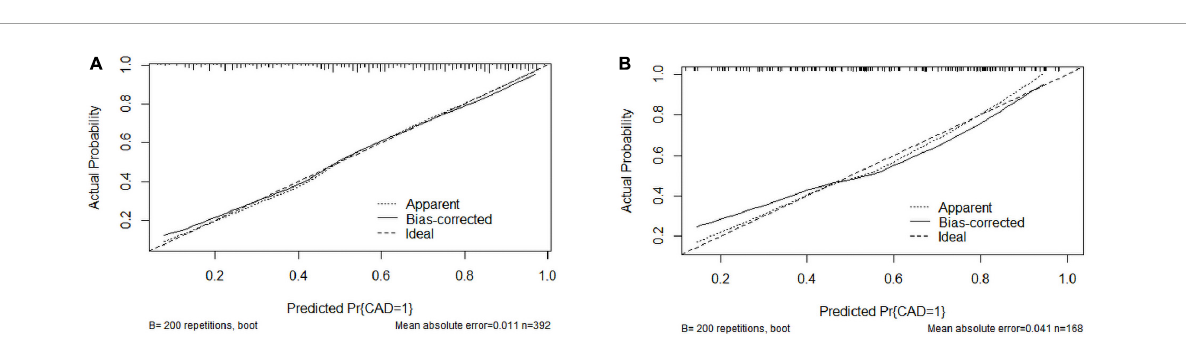
FIGURE4 Calibration curves of the coronary heart disease (CHD) prediction nomogram. (A) Calibration curve of the CHD prediction nomogram in the training cohort; (B) Calibration curve of the CHD prediction nomogram in the validation cohort.